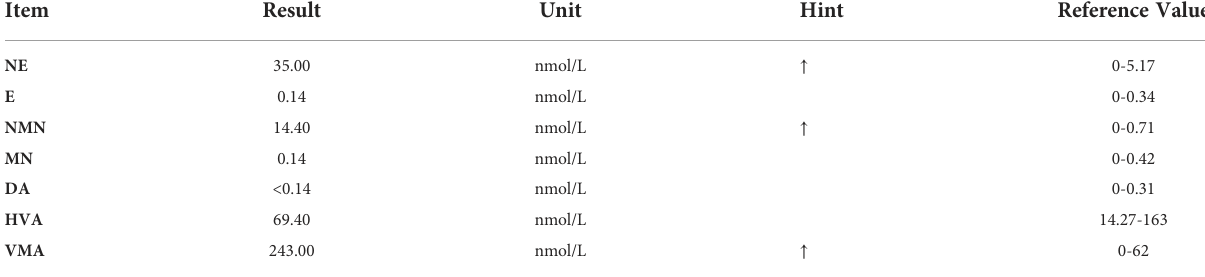
TABLE 3 Plasma catecholamine concentrations (recurrence treatment).